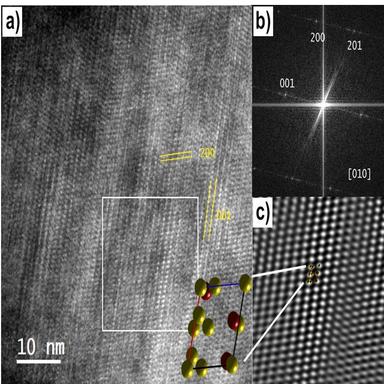
a) HRTEM image obtained on a Fe4Al13 grain, together with the FFT (b) and inverse FFT (c) of the area enclosed in the white box.